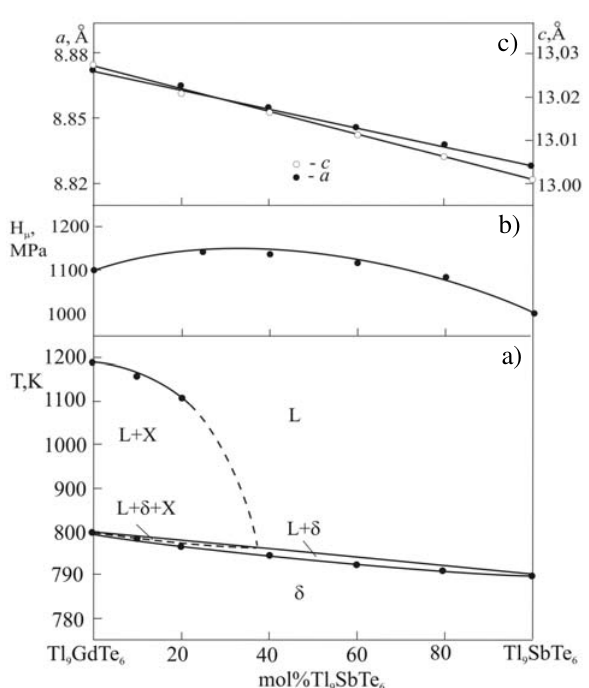
Te - 5 3 Fig. 2. Polythermal section (a), concentration relations of micro- hardnesses (b), and lattice parameters (c) for the system Tl Tl SbTe 9